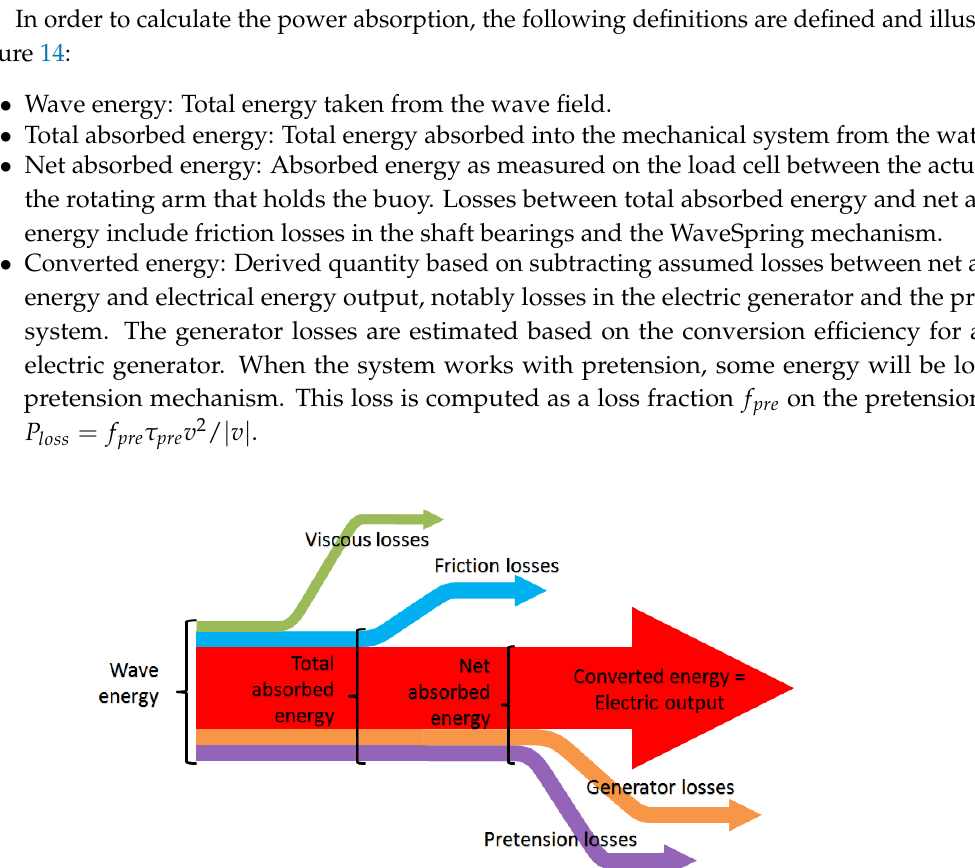
Figure 13. Buoy motion for regular wave Rf5, comparing the responses of Setups 1 and 4. In the left diagram, the buoy travel is expressed as excursion along the circular path through point B with the center at pivot A , cf. Figure 2. All signals have their mean values extracted.